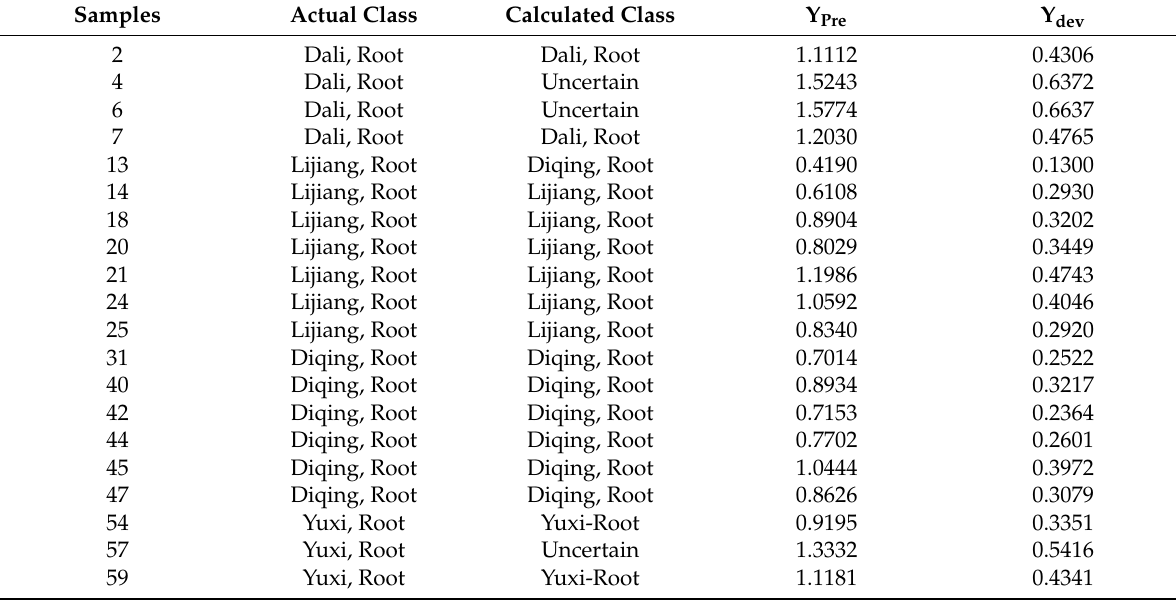
Table 2. Results of the PLS-DA model 1 validation set